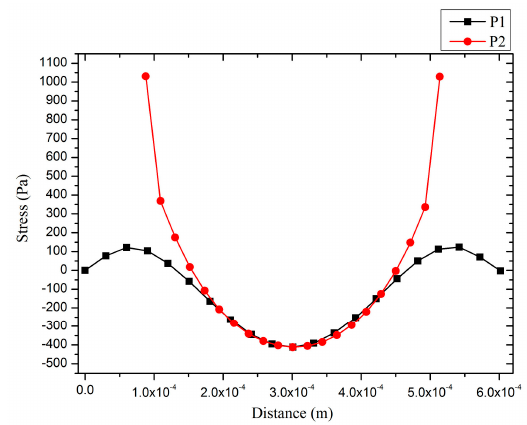
Figure 6. The stresses distributions in piezoelectric film of pMUT with whole electrode.